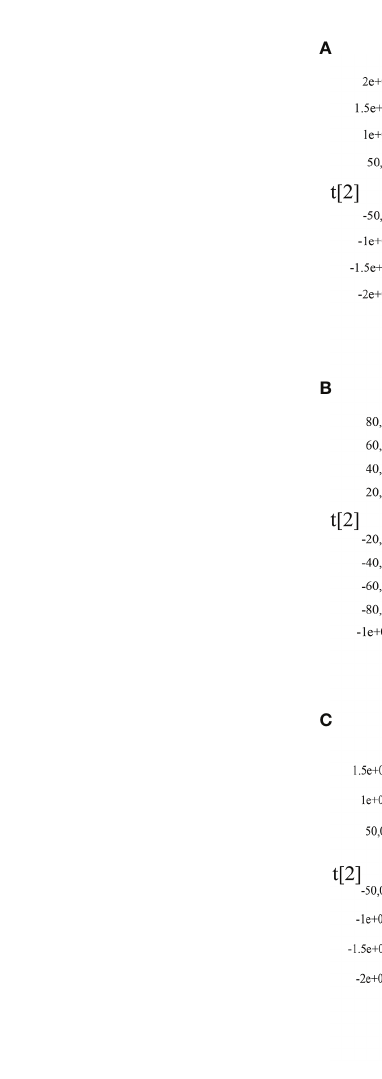
FIGURE 6 | Multivariate statistical analyses to reveal the difference in plasma metabolic pro fi ling between the H and LUAD groups. (A) Unsupervised analysis method: PCA. Supervised analysis methods: (B) PLS-DA and (C) OPLS-DA. PLS-DA, Partial least-squares discrimination analysis; OPLS-DA, Orthogonal partial least-squares discrimination